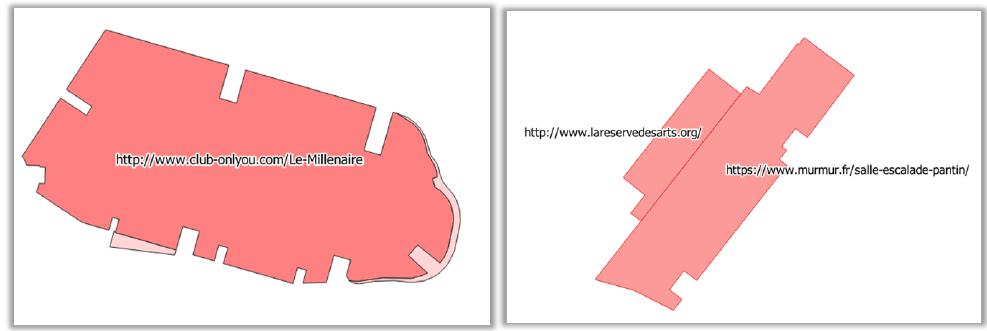
Figure 10. False positives detected by the model trained on Aubervilliers and applied to the neighbouring city of Pantin, caused by the max _ special _ ratio feature.